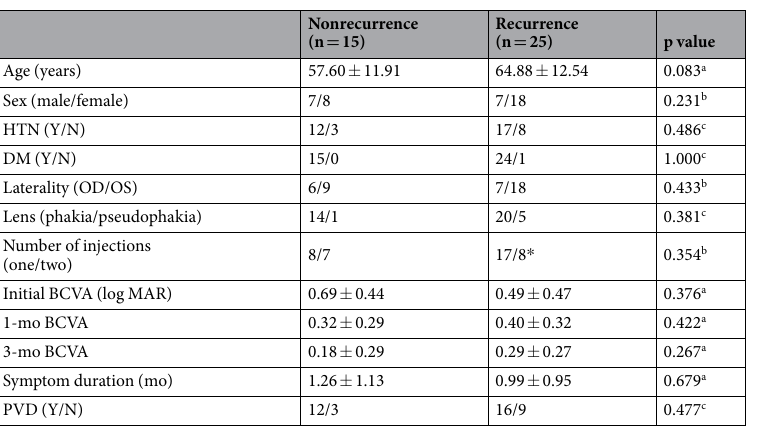
Recurrence (n = 25) p value